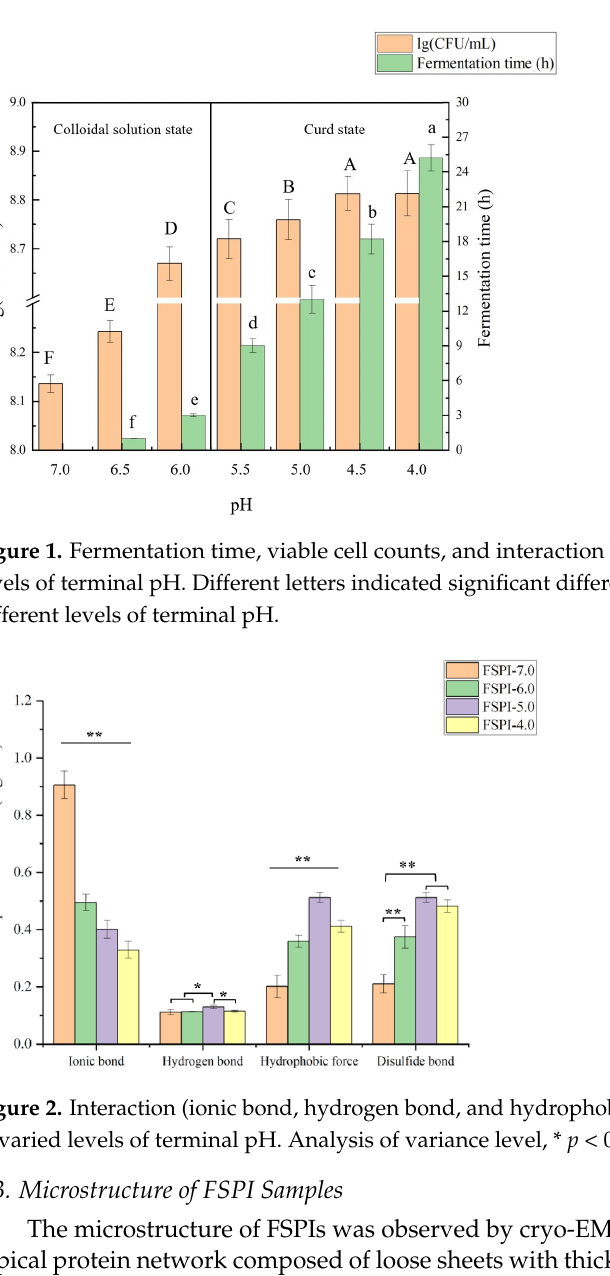
Figure 1. Fermentation time, viable cell counts, and interaction between proteins of FSPI at varied levels of terminal pH. Different letters indicated significant difference ( p < 0.05) between the FSPIs at different levels of terminal pH.